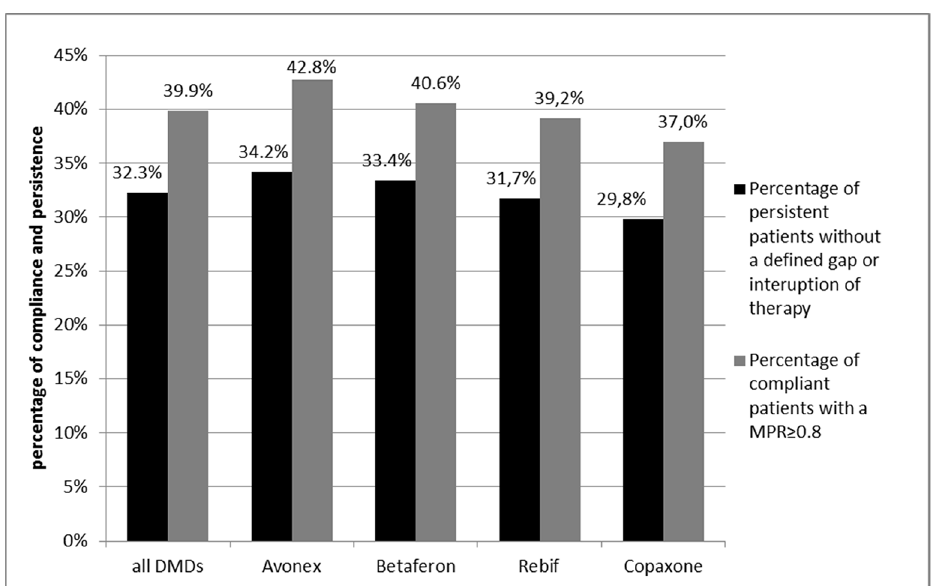
Fig 5. Main analysis: Overview of compliance and persistence in the DMD groups over an observation period of 24 months.